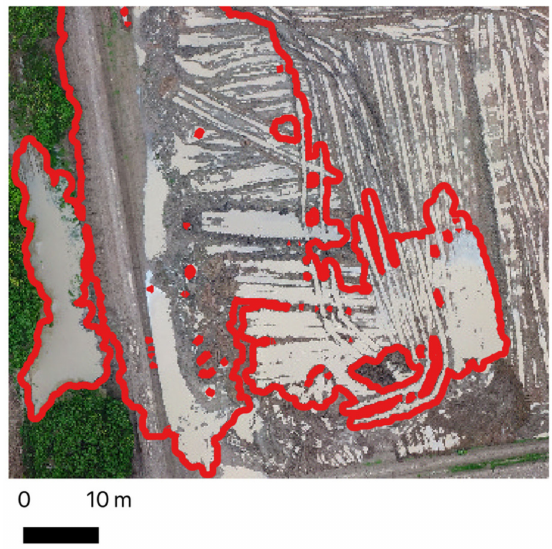
Figure 7. Over classification of open water due to spectral similarity with neighbouring bare soil and mud.